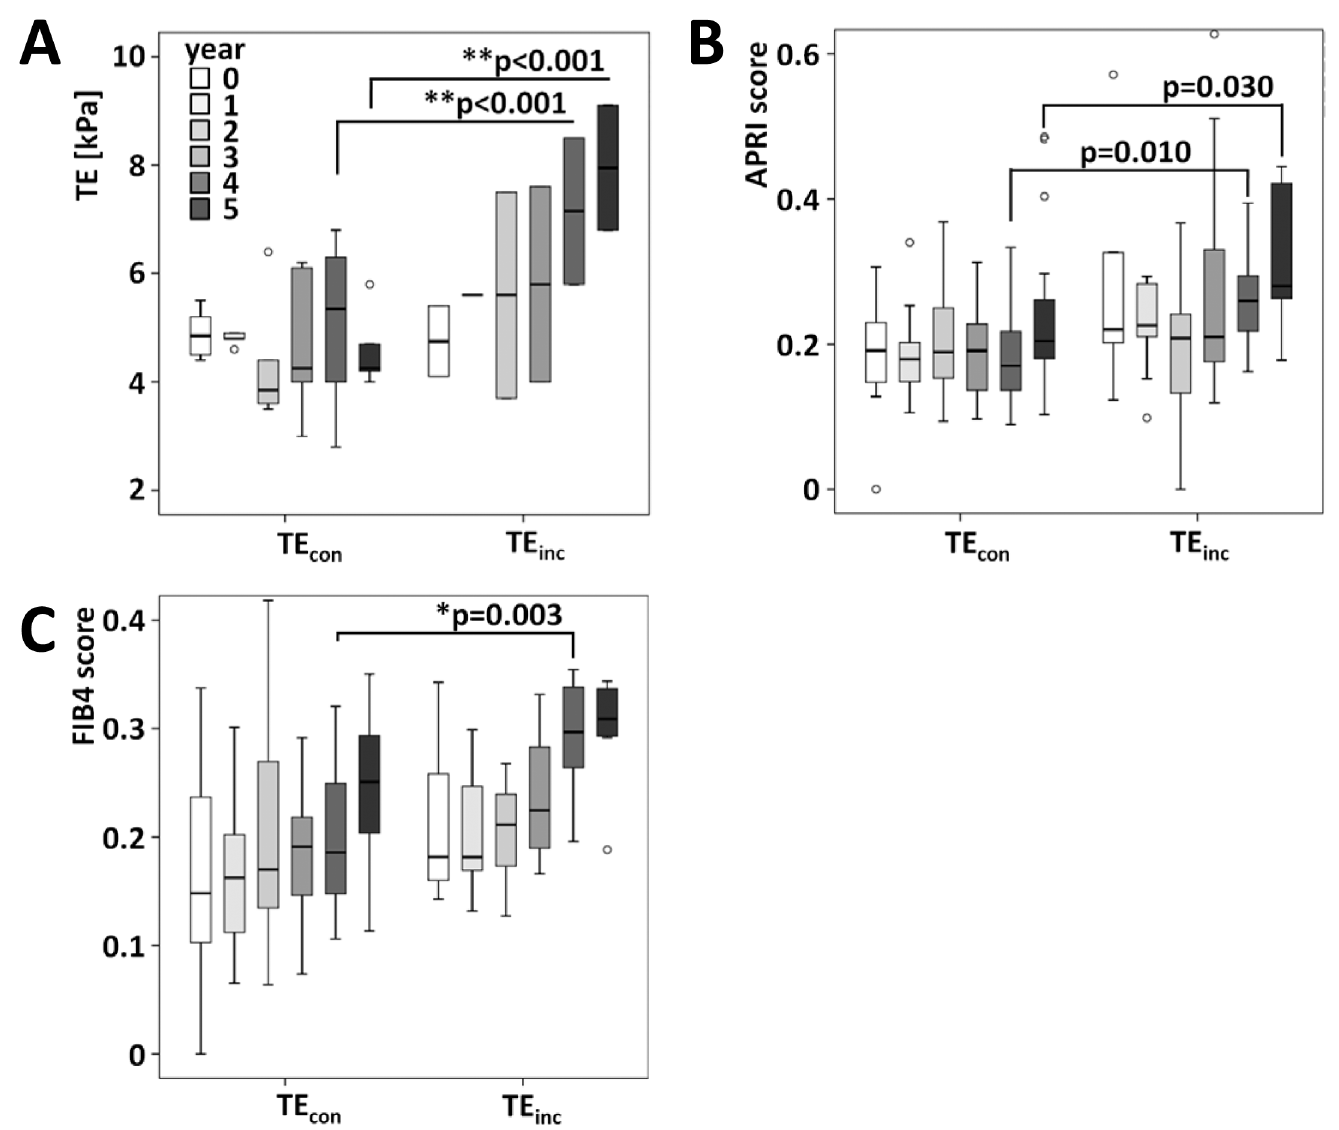
Fig 3. The longitudinal assessment of TE, APRI-score, and FIB-4-score indicated increased liver stiffness and fibrosis. (A) TE was enhanced in the TE inc -group 4 and 5 years after the first assessment. (B) Althoughthe ANOVA calculated p -valuewas rather low in comparisonof TE inc and TE con 4–5 years after the first examination, statistical significancewas not reached. (C) FIB-4 was enhanced in patients of the TE inc -group 4 years after the first examination, howeverit did not reach statistical significanceat the 5 th exploration.Interestingly, the FIB-4-score tends to increasegraduallyin patients of the TE con